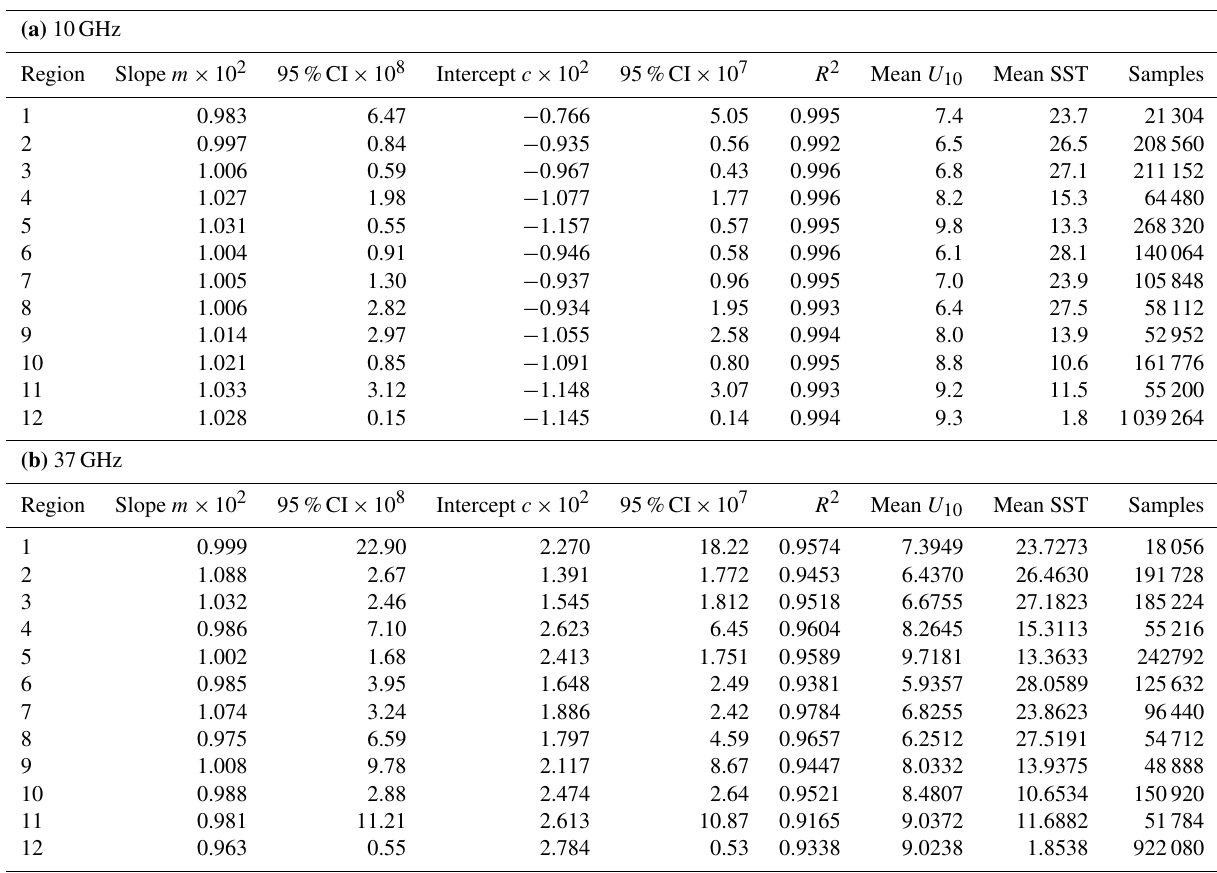
Table 4. Results for slope (coefficient m ) and intercept (coefficient c ) with their 95% confidential intervals (CI) from Eq. (8b) applied to satellite-based W data for March 2006 for all 12 regions for (a) 10GHz data; (b) 37GHz data. Mean wind speed U 10 and sea surface temperature (SST) T for each region are also given. Such data were obtained for all